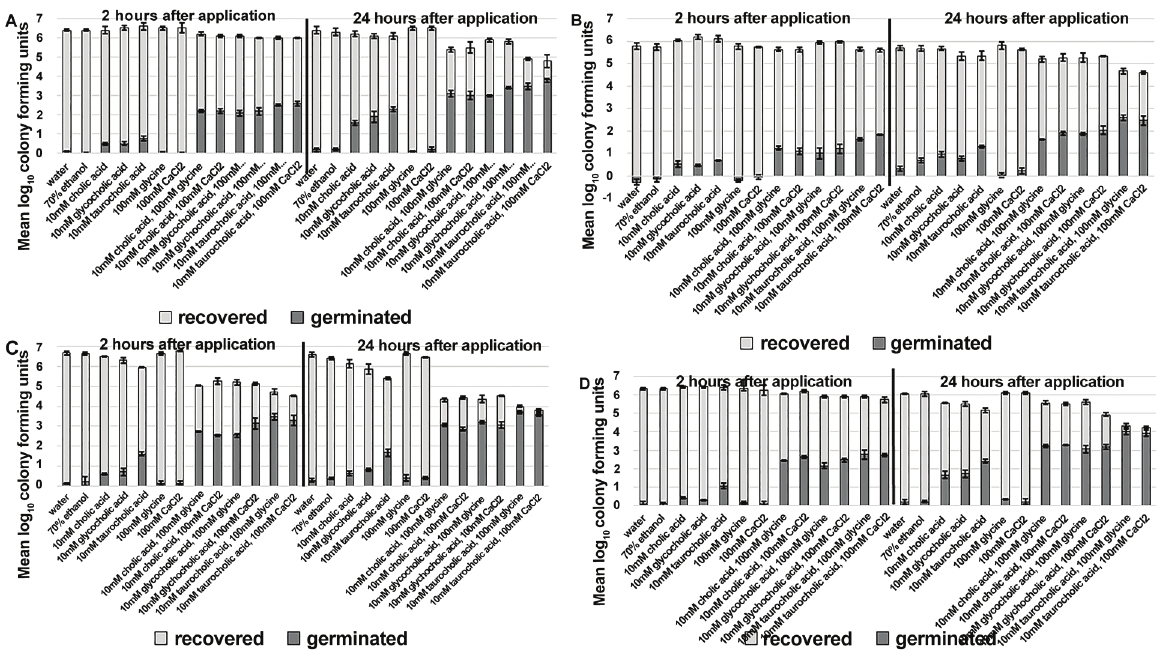
Figure 1. Recovery of Clostridium difficile spores from an ex vivo porcine skin model is reduced after sensitizing spores with a single application of germinants. Sections of porcine skin (1 cm 2 ) were inocu- lated with 7 log colony forming units (CFU) of C. difficile R20291 (A), VA17 (B), ATCC 43598 (C), and 10 ATCC 43593 (D). Then 50 µ L of test solution was applied once and rubbed into each skin section until absorbed. After 2 or 24 hours of incubation at room temperature, the spores were recovered from skin sec- tions and the log CFU of viable and germinated spores was determined. The means of data from triplicate 10 experiments are presented. Error bars indicate standard